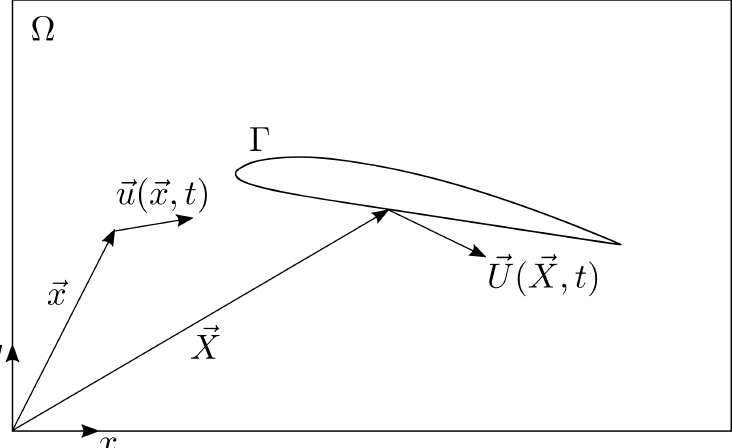
Figure 1. Representation of the Eulerian domain ( Ω ) and the Lagrangian domain ( Γ ), where x is the position vector of any point in the Eulerian domain and X is the position vector of any point in the Lagrangian